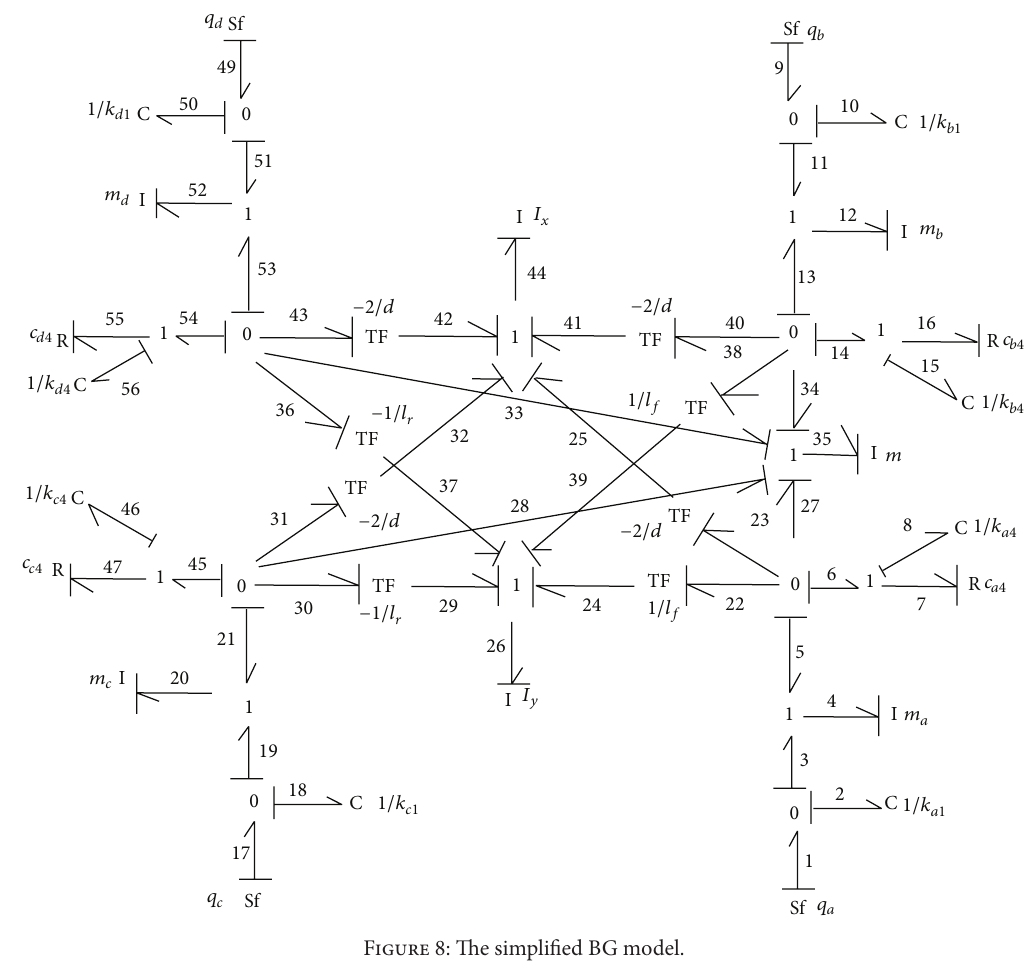
Figure 8: The simplified BG model.